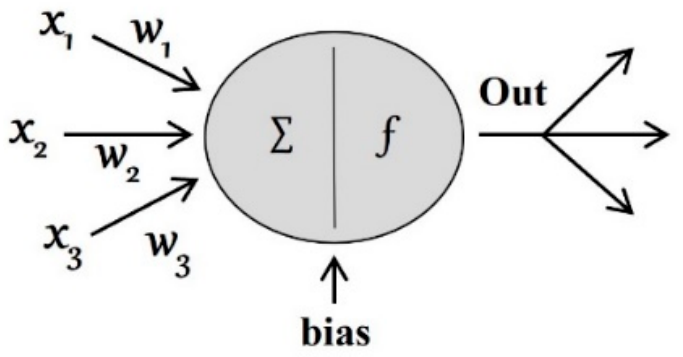
Figure 2. Conceptual diagram of the perceptron.